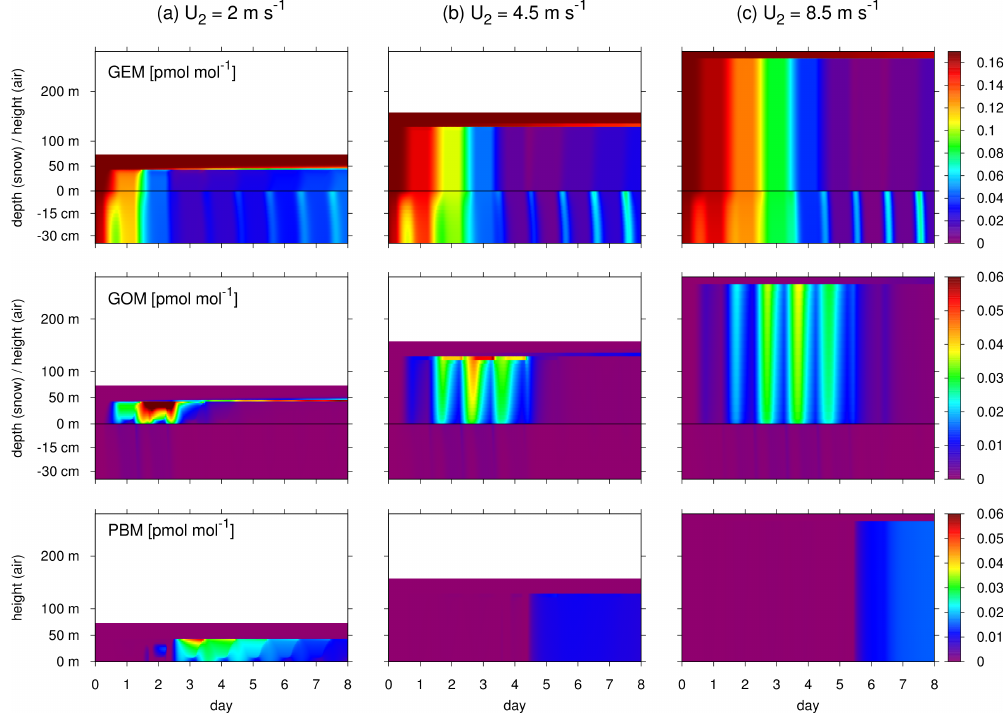
Fig. 3. Time-height cross sections for the mixing ratios of GEM (top row), GOM (middle row), and PBM (bottom row) from model runs employing scenario 1A at U 2 = 2 . 0 m s − 1 (a) , 4.5 ms − 1 (b) , and 8.5 ms − 1 (c) .